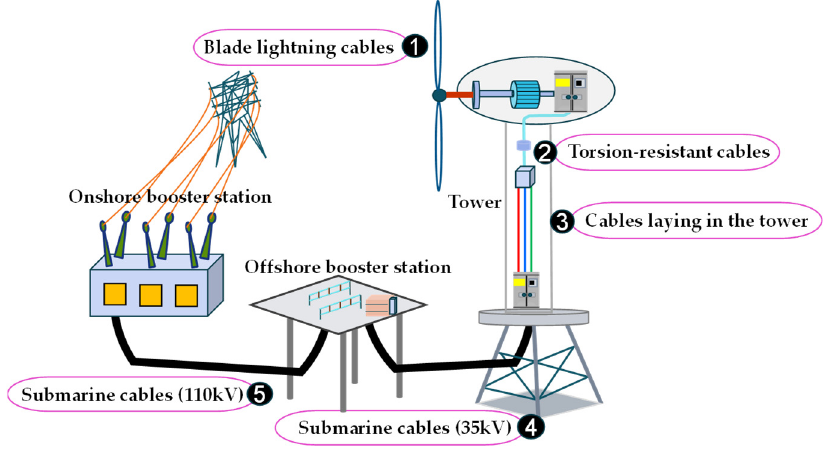
Figure 1. Schematic diagram of the cables used in offshore wind power generation systems.